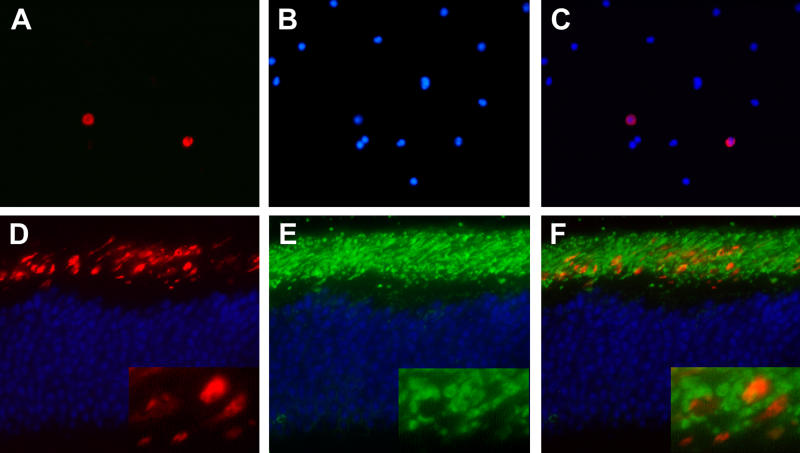
S-Opsin Dissociated Cell In Situ Hybridization and S-Opsin/Rhodopsin Antibody Staining on rd7 Mutant Retina(A–C) A dissociated cell in situ hybridization with an S-opsin probe (red) on dissociated rd7 mutant retinal cells stained with DAPI (blue). (C) shows the merged images.(D–F) The outer nuclear layer of an rd7 mutant retina stained by antibody for S-opsin (red) and rhodopsin (green). The scleral edge of the outer nuclear layer is up. DAPI staining is in blue. (F) shows the merged images. Insets are higher-power images of the outer segments showing non-overlap of S-opsin and rhodopsin staining in the mutant.